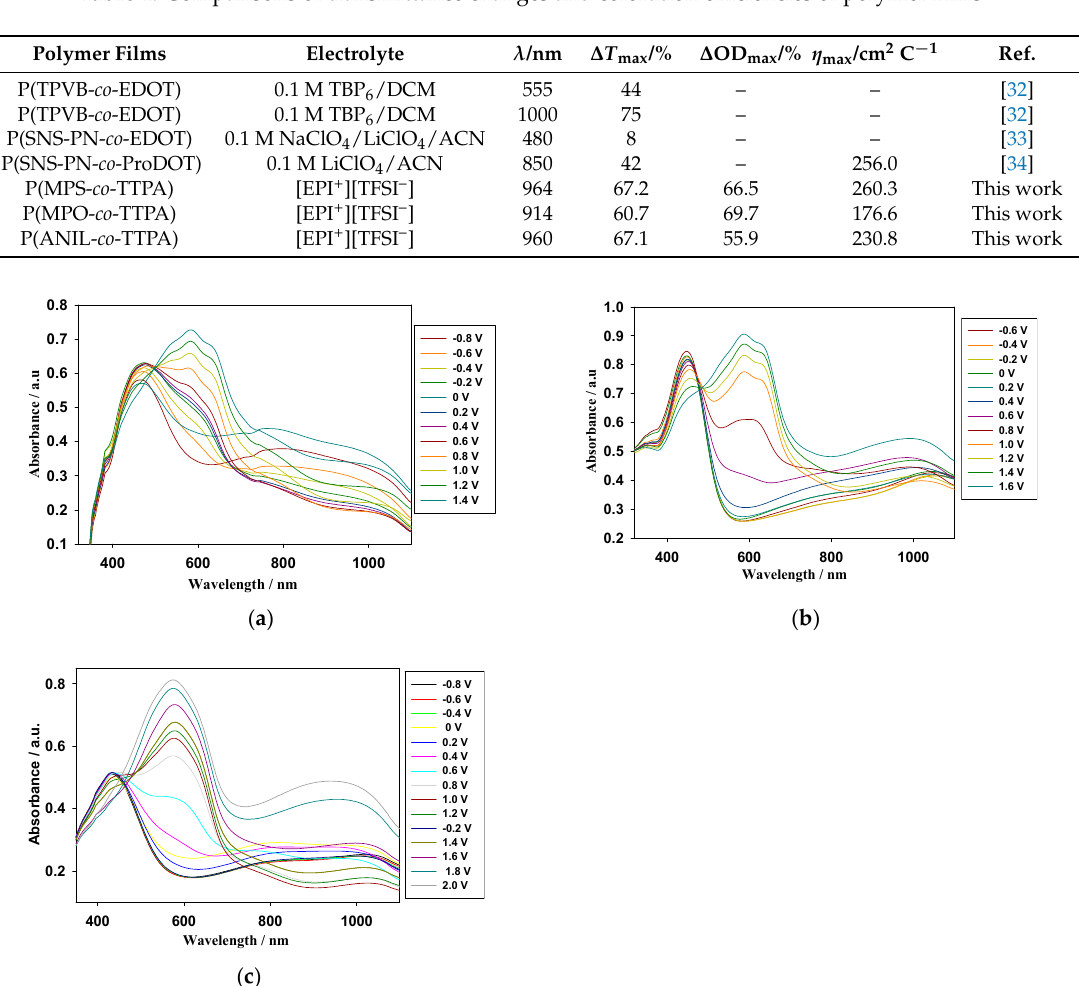
Table 4. Comparisons of transmittance changes and coloration efficiencies of polymer films.